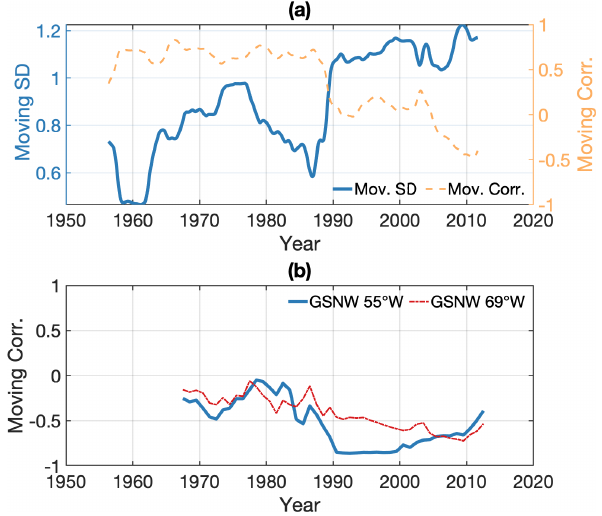
Figure 7. (a) Moving standard deviation of α 2 with a 15-year run- ning window (solid blue line) and moving correlation with the same windowing between the northern and southern Atlantic gauge grouping averages (orange dashed line). The latter is the same as the blue line in Fig. 4a. (b) Moving correlation with a 15-year run- ning window between the second principal component α 2 and our GSNW index (solid blue line) and between α 2 and our GSNW in- dex computed on 75–69 ◦ W (dot-dashed red